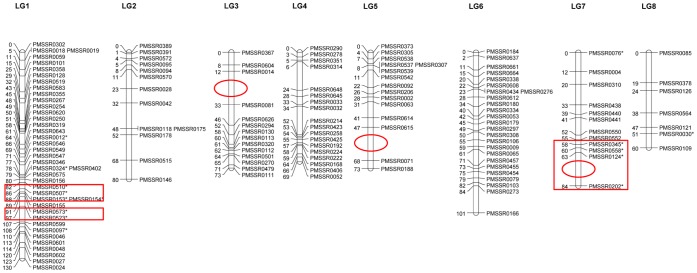
Framework genetic map of P. mume ‘Fenban’×P. mume ‘Kouzi Yudie’.Numbers to the left of each LG are marker positions identified in cM. Markers that show distorted segregation distributions are starred (*; P<0.05). Ovals indicated gaps are greater than 20 cM. SDRs are shown by boxes.